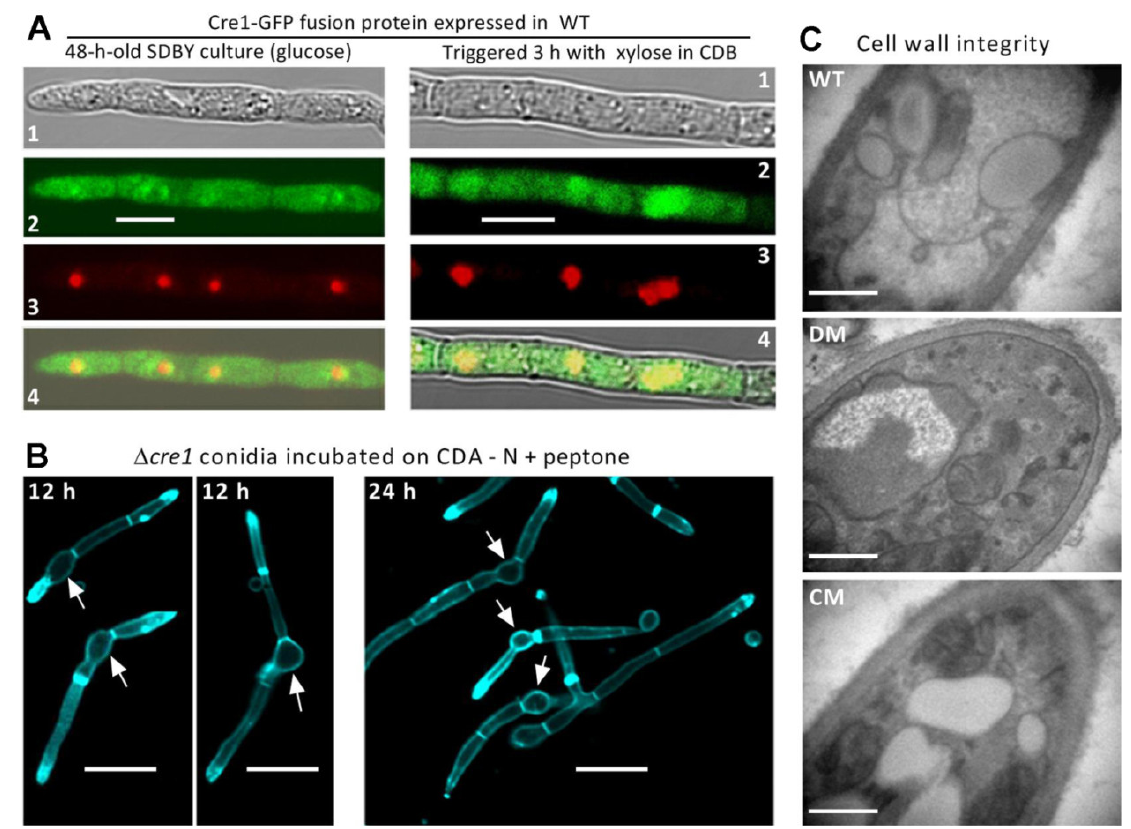
Figure 1. Subcellular localization of Cre1 and its role in the cell lysis of B. bassiana . ( A ) LSCM images (scale bar: 5 μm) for subcellular localization of Cre1-GFP fusion protein in the hyphal cells stained with the nuclear dye DAPI (shown in red) after collection from a 48-h-old culture grown in SDBY containing glucose (left panels) and then triggered for 3 h with xylose (right panels). Panels 1, 2, 3 and 4 are bright, expressed, stained and merged views of the same field. ( B ) LSCM images (scale bar: 10μm) of germ tubes formed after 12 or 24 h incubation of Δ cre1 conidia (arrowed) on CDA amended with peptone as sole nitrogen source. Note no sign of cell lysis occurring at the base of germ tube. ( C ) Cell wall integrity presented by TEM images (scale bar: 0.5 μm) of ultrathin sections from the hyphal cells of the wild-type (WT), Δ cre1 (DM) and Δ cre1::cre1 (CM) strains.